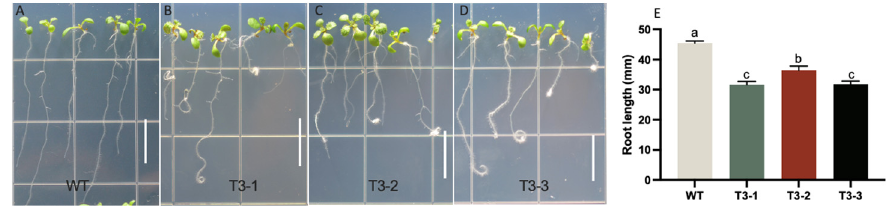
Figure 5. Root phenotypes of Arabidopsis p35S: LhWOX5 . Analysis of four individual lines, using 8-day-old seedlings for quantification. ( A ) WT, wild type (n = 162). ( B ) Line T3-1 (n = 185). ( C ) Line T3-2 (n = 172). ( D ) Line T3-3 (n = 199). Scale bar = 1 cm. ( E ) Root length in mm, the average ± SE is shown. An ANOVA test was used for statistical analysis. The letters a, b, and c indicate significant differences, with groups marked by identical letters having no significant difference between them. Table 2. The analysis of curly roots in p35S:LhWOX5 .